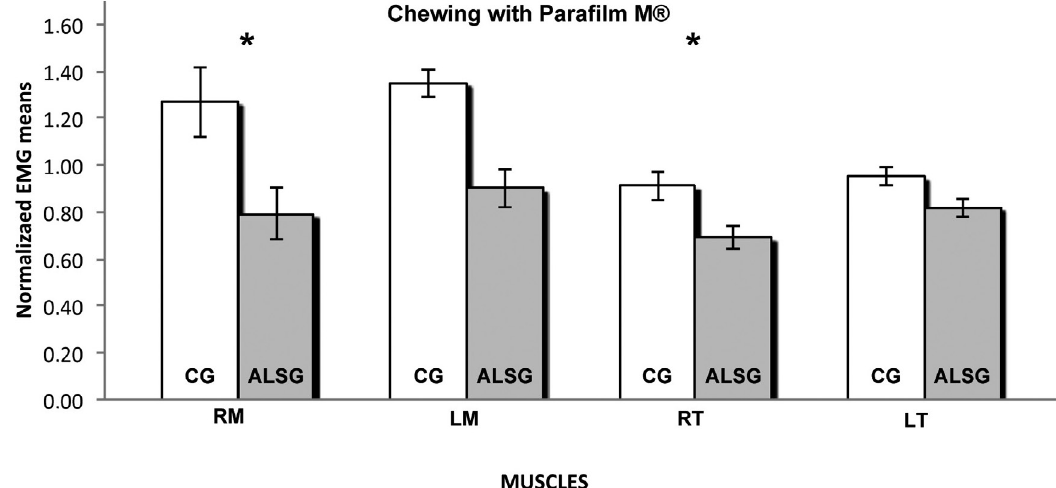
Figure 8- Normalized electromyography data of masseter (RM: right masseter; LM: left masseter) and temporalis (RT: right temporal; LT: left temporal) muscles for CG and ALSG in the chewing with Parafilm M ® . *statistically significant difference (p≤0.05)